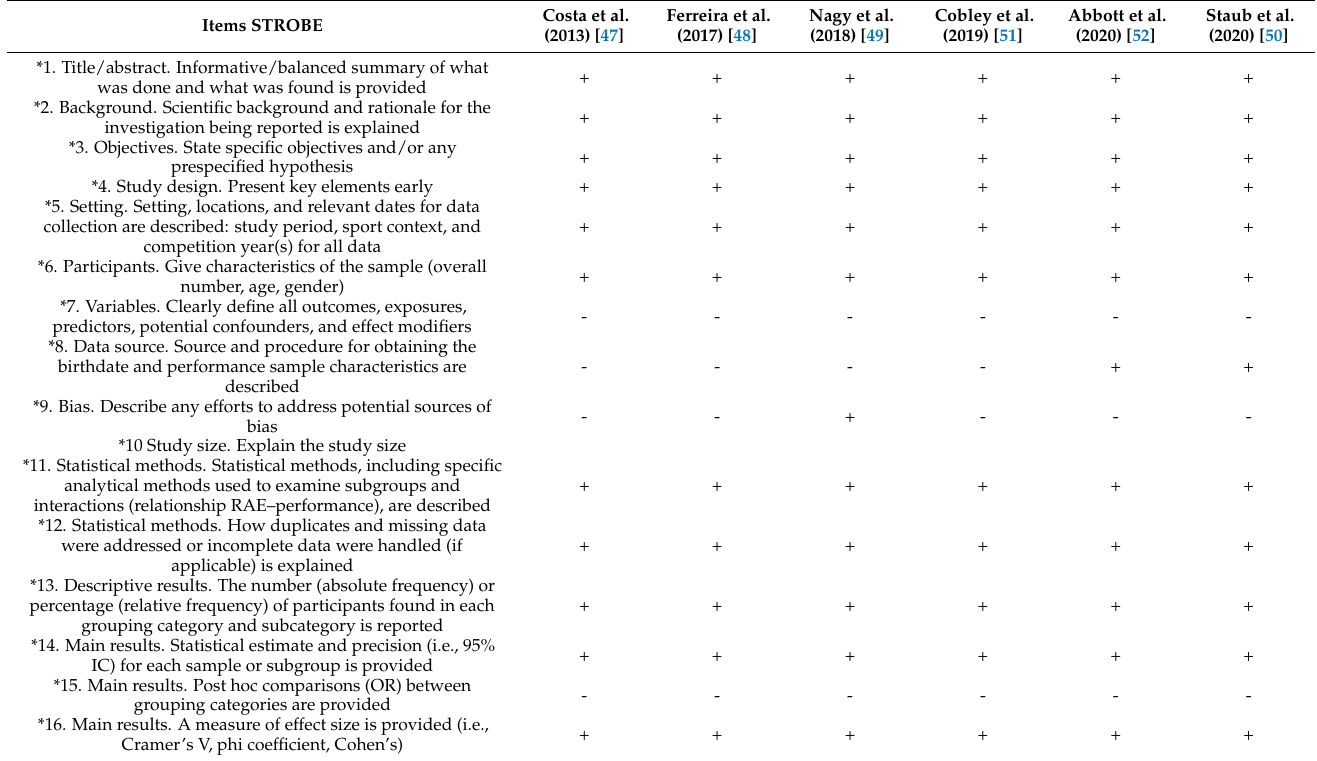
Figure 3. Impact of the RAE on competition performance in short-distance events according to age group and style. Table 5. Study quality assessment based on the adapted version of Strengthening the Reporting of Observational Studies in Epidemiology